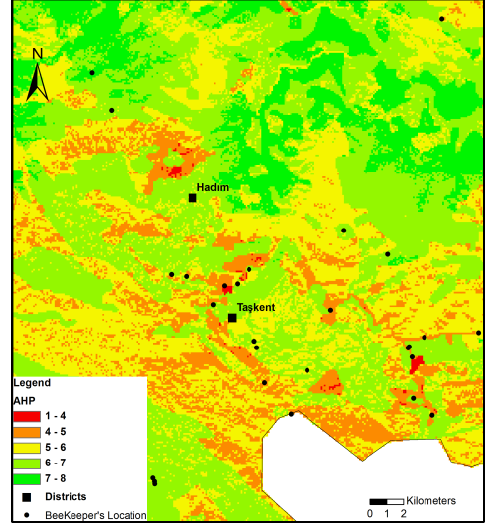
Figure 7. Existing bekeeper locations (Detailed